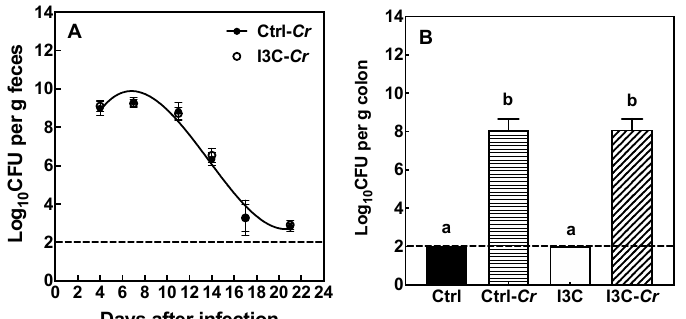
Figure 3. I3C has no impact on Cr burden in feces and colon of Cr-susceptible C3H / HeN mice. Mice were infected orally with approximately 2.5 × 10 9 CFU of Cr. ( A ): Fecal excretion of Cr. The fecal pellets of mice were collected on di ff erent days after infection and the Cr load in feces (cfu / g feces) were determined. ( B ): Colonic colonization of Cr. Mice were sacrificed on day 12-post-infection and the amount of colon tissue associated Cr was determined. Results were expressed as mean +/ − SD (n = 8). Ctrl: control diet; Ctrl-Cr: control diet, Cr-infected; I3C: I3C diet; I3C-Cr: I3C diet, Cr-infected. The dashed line indicates the limit of detection of the assay. Significant differences ( p < 0.05) between groups are identified by different letters.